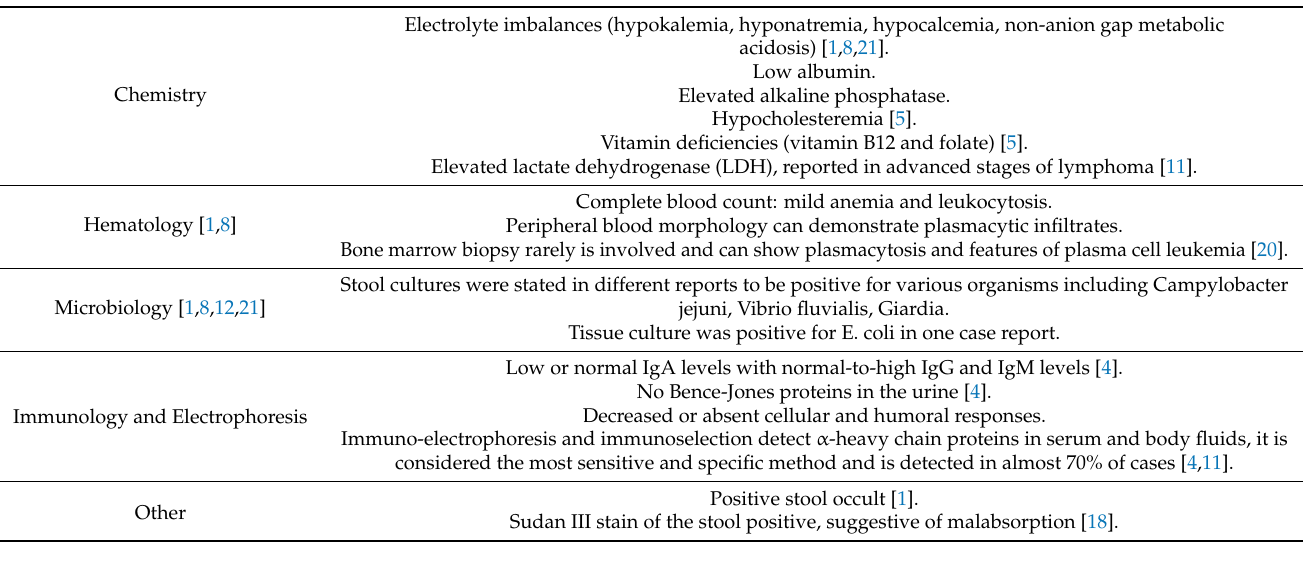
Table 1. Investigational features reported on in the literature in patients diagnosed with IPSID.